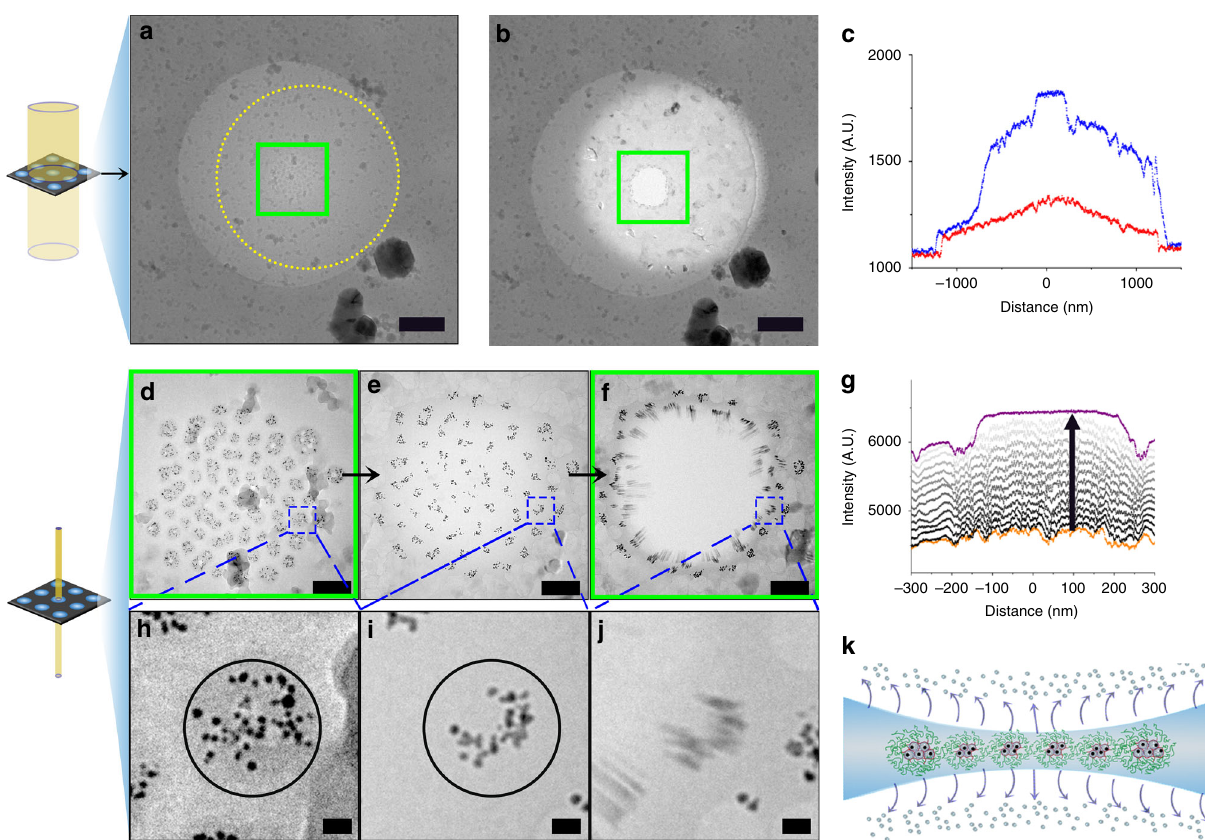
Fig. 3 The effect of stroboscopic electron exposure on a nanoparticle-containing dendrimicelle superstructure. a CryoTEM micrograph of a generation-six based dendrimicelle superstructure obtained at low electron fl ux. b CryoTEM micrograph obtained after high electron fl ux stroboscopic exposure series. The high electron fl ux irradiation resulted in the evaporation of water from the irradiated area, decreasing the local thickness of the water fi lm, corresponding to a lighter color. The yellow dotted circle in a indicates the size of the electron beam used for the exposure series, and the green solid square in a and e show the area of the superstructure that is captured by the microscope ’ s camera during the high electron fl ux stroboscopic irradiation. c The image intensity plot over the cryoTEM gridholes shown in a (in red) and b (in blue) shows that the stroboscopic exposure series resulted in an increase in the image intensity values, corresponding to a decrease in thickness. d – f CryoTEM micrographs during high electron fl ux stroboscopic irradiation, showing: d the dendrimicelle superstructure at the start of irradiation, e just before the nanoexplosion, and f right after the nanoexplosion.The dashed blue boxes in d – f indicate the superstructure area that has been enlarged in panels h – j . g Image intensity plot during the high fl ux stroboscopic irradiation series. The graph shows that exposure yielded a gradual increase in image intensity values, corresponding to a decrease of the fi lm thickness in the irradiated area. h – j Enlarged versions of the corresponding micrographs as shown in d – f , respectively, showing a single dendrimicelle during the exposure series. The black, solid circle in h, i illustrate the original dendrimicelle core area. k Cartoon illustrating the induced water evaporation during the stroboscopic exposure. Scale bars are 500 nm in a , b , 100 nm in d – f , and 10 nm in h –